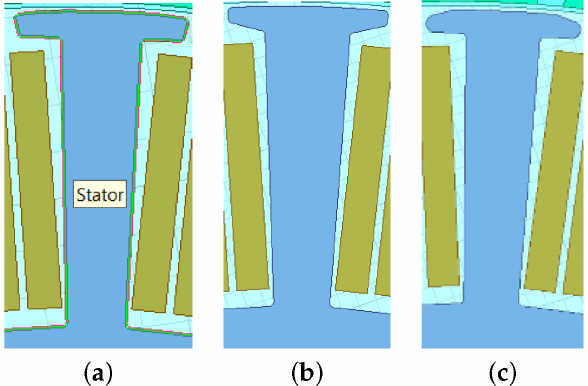
Figure 15. Stator slot types used in the design: ( a ) Slot − 1; ( b ) Slot − 2; ( c ) Slot −